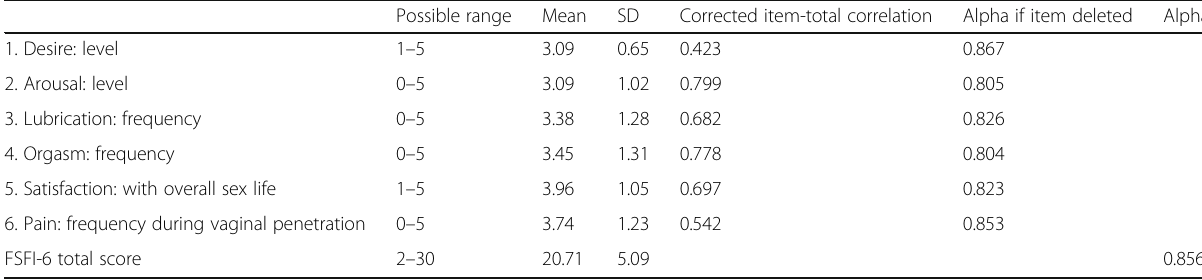
Table 2 Item wording and descriptive statistics and internal consistency of the FSFI-6